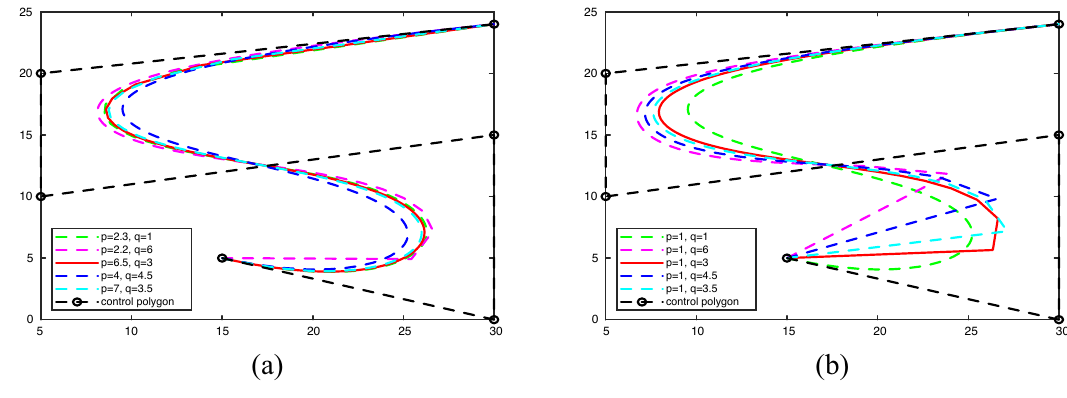
Figure 4: Comparison of weighted Lupa ş p q , ( ) - Bézier curves for weights w 1, 2, 4, 4, 4, 1 [ ] = . ( a ) Weighted Lupa ş p q , ( ) - Bézier curve, ( b ) weighted Lupa ş q - Bézier